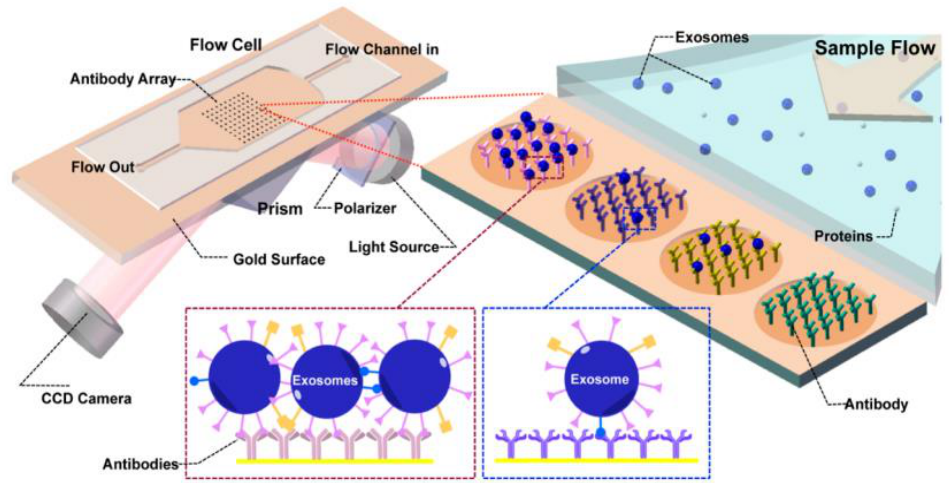
Figure 19. Label-free SPRi method for the detection and characterization of tumour-derived exosomes. Schematic view of SPRi combined with antibody microarray and measurement setup. (Reproduced from Zhu L. et al. [84]. Copyright 2014, Anal Chem.).